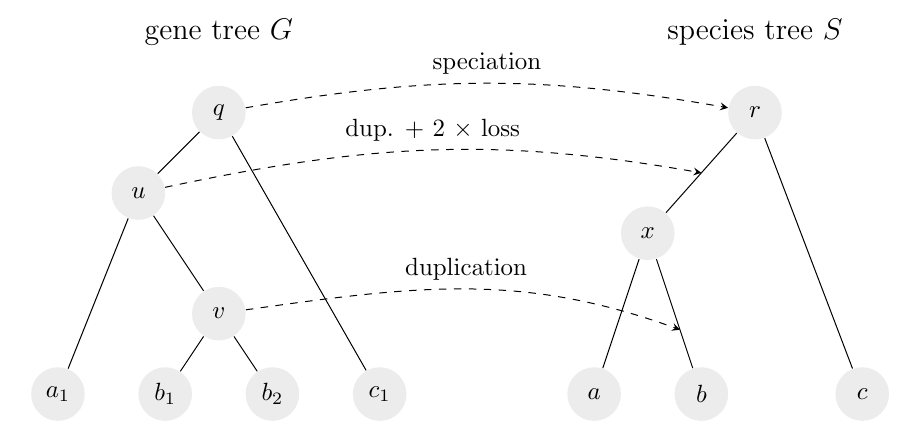
Figure 1. An example of a reconciliation of a gene tree and a species tree. Leaves of the gene tree are labeled by the species of origin; for example, b 1 and b 2 are genes from species b . In the history implied by the reconciliation, there was originally a single copy of the gene, which underwent speciation corresponding to nodes q and r and was passed without change to species c . On the other lineage, the gene was first duplicated (node u ), and then underwent speciation in node x , followed by one loss in each of the new lineages. As a result, species a had only one copy of the gene. Finally, the gene was again duplicated on the edge leading to b (node v ). Note that if u was mapped to node x by the reconciliation, there would be only a single duplication (node v ) and no losses in the corresponding